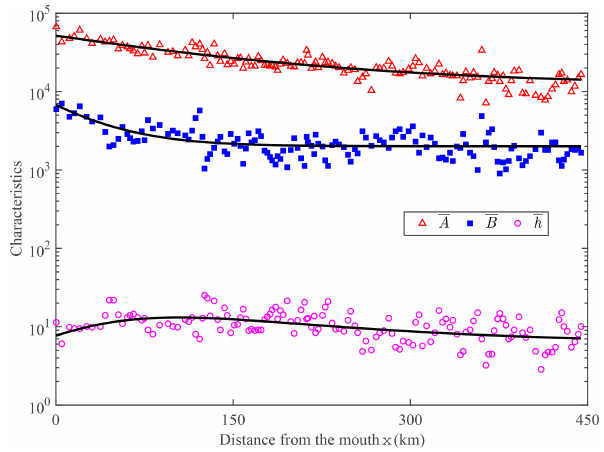
Figure 4. Longitudinal variation of the main geometric characteris- tics (cross-sectional area, width and depth) along the Yangtze River estuary. The thick black lines represent the best-fitting curves.